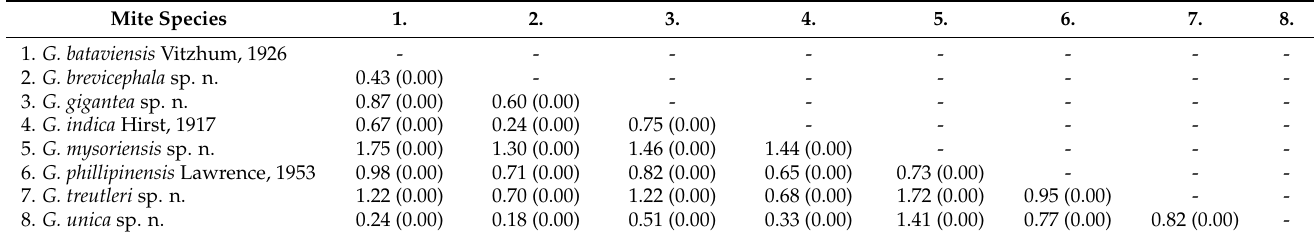
Table 7. Kimura two-parameter distances (presented as percentages with standard error estimates in parentheses) between 18S sequences of analysed Geckobia species. The analysis included 35